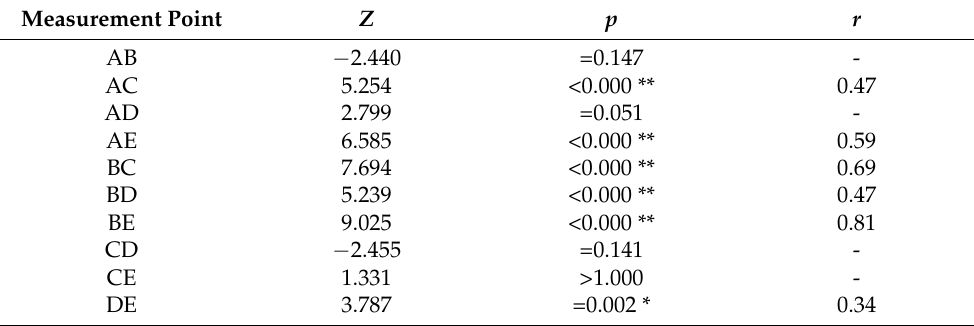
Table A1. Ceramic 3y_DD ( χ 2 (4) = 110.00; p < 0.000); N =